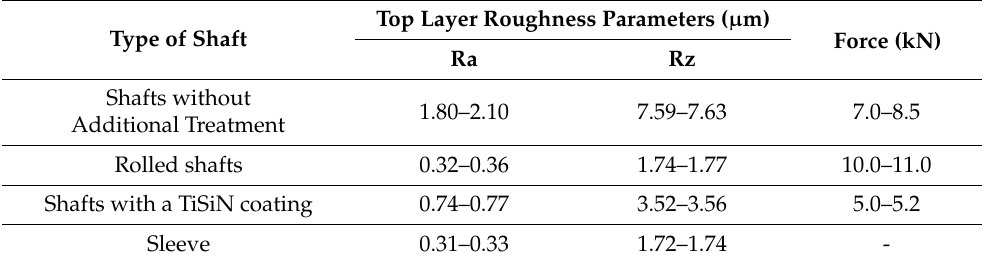
Table 2. The values of roughness parameters (Ra, Rz) of the shaft and sleeve top layer and the value of the force needed to press the sleeve onto the shaft.